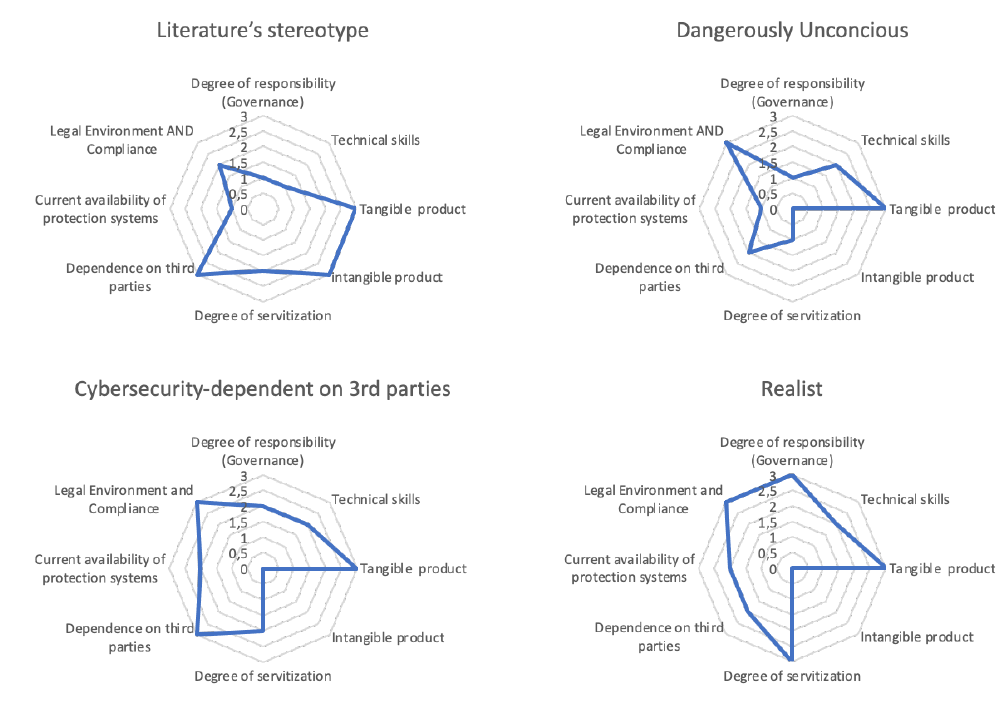
Figure 2. SMEs cybersecurity readiness ideal